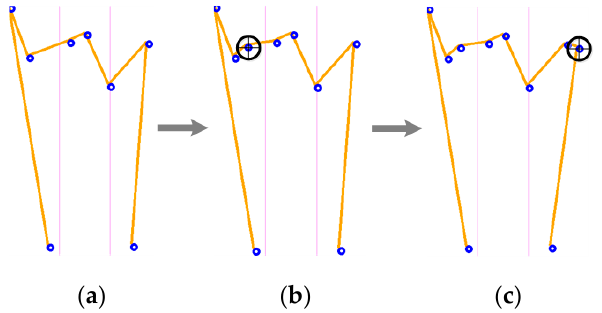
Figure 12. Characteristic array adjustment, ( a ) characteristic array of size 8; ( b ) characteristic array of size 9; ( c ) final characteristic array of size 10.